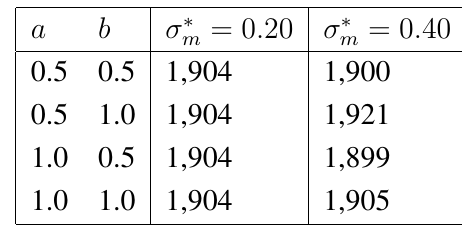
under Stochastic 0 , 20